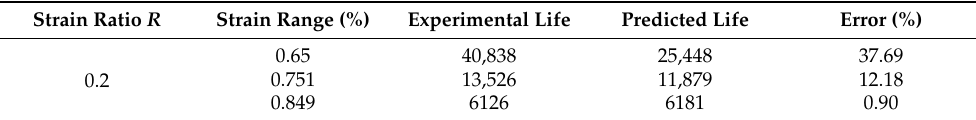
Table 7. Life prediction of non-destructive specimens with R =